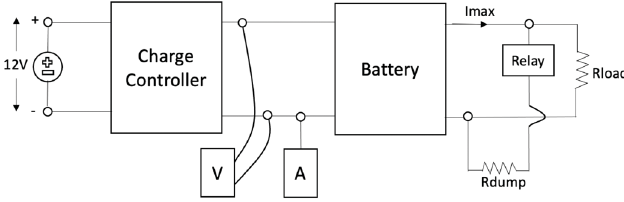
Fig. 8. Circuit diagram showing the methods to utilise the surplus energy with